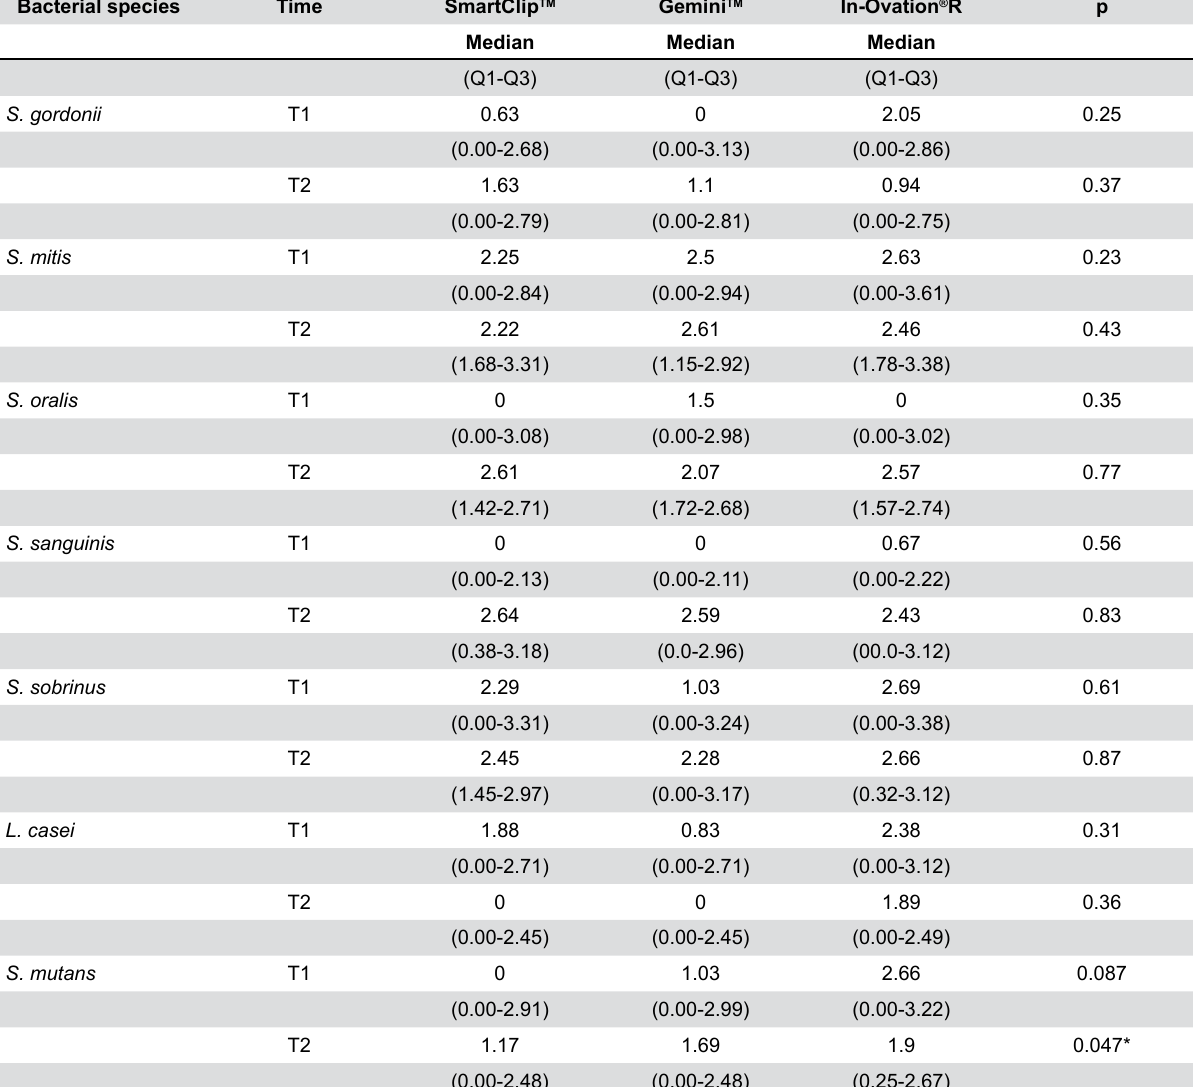
Microbial species associated with dental caries found in saliva and in situ after use of self-ligating and conventional Table 2- Microbial count (µg x 10 5 ) in situ sample